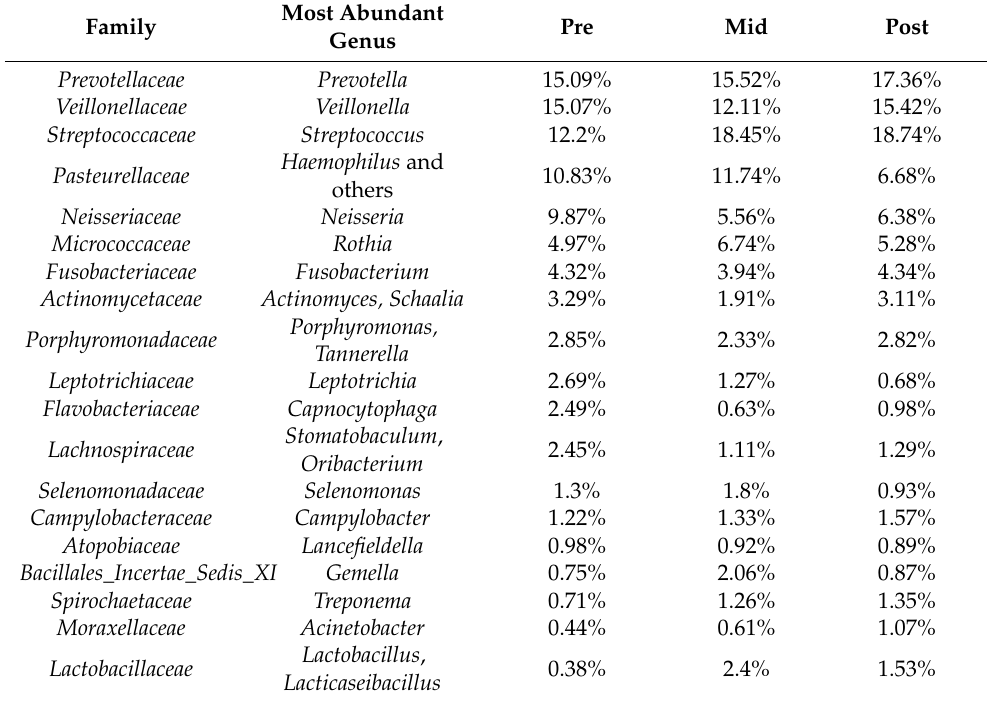
Table 3. Relative abundance profile (Family level) of the total oral microbiome with changes at the three different time